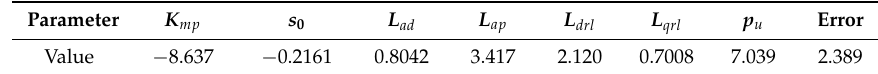
Table 3. Parameter estimated value.